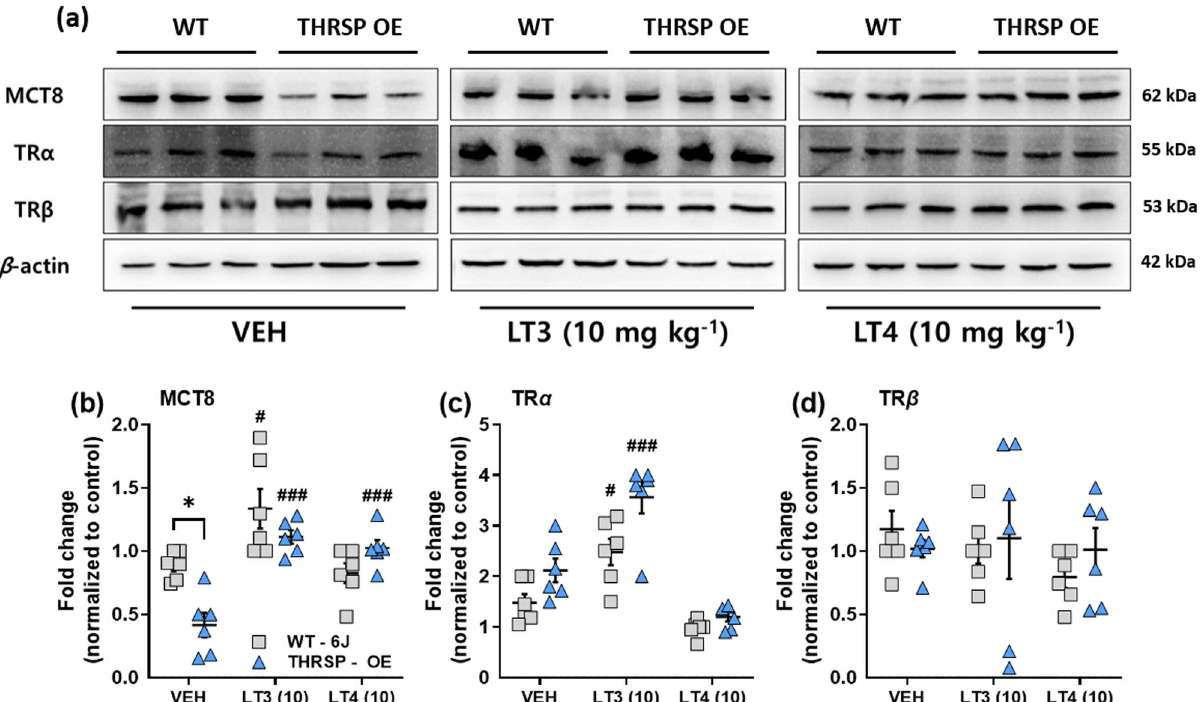
Fig. 10 Effects of TH replacement on TH-related proteins in THRSP OE mice. The TH-related proteins were evaluated following 7 days of LT3 and LT4 (10 mg kg − 1 ) treatment. On the last day of the treatment, the brains were harvested, and the striatum was subjected to western blot analysis. a Representative blots for speci fi c protein targets. b MCT8, c TR α , and d TR β protein levels ( n = 6 mice/group; b two-way ANOVA, F (1,30) = 4.96, P = 0.034; c two-way ANOVA, F = 14.4, P < 0.001; d two-way ANOVA, F = 0.123, P = 0.728). TH replacement improved the striatal MCT8 and (1,30) (1,30) TR α levels in THRSP OE mice. Values are presented as the mean ± S.E.M. * P < 0.05 (relative to WT) and # P < 0.05. ## P < 0.01 (relative to VEH treatment), by two-way ANOVA with Bonferroni ’ s multiple comparison